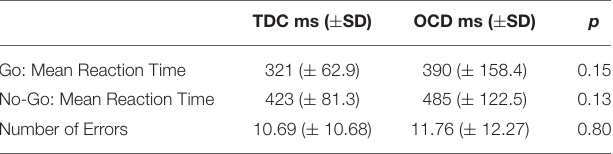
TABLE 2 | Behavioral performance across reaction